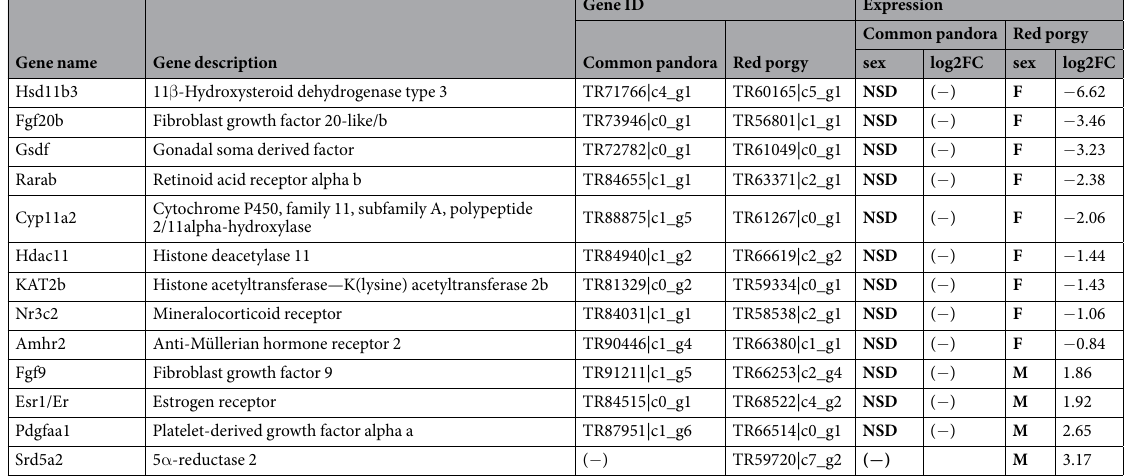
sex-biased expression in both brains and gonads were over-expressed in female brains. Zona pellucida proteins are glycoproteins of the fish chorion that are encoded by multiple gene families. In humans and mice, but also in some teleosts 59–61 , they are expressed in the ovary. In addition, several factors of the Sox gene family, as well as sev- eral members of the Forkhead box transcription factor ( Fox ) family were detected, which might play important roles in the brain of these protogynous fish. The comparative analysis revealed commonly over-expressed genes in in synaptic function, regulating neurotransmitter receptor trafficking to synapses 62 . A male over-expression